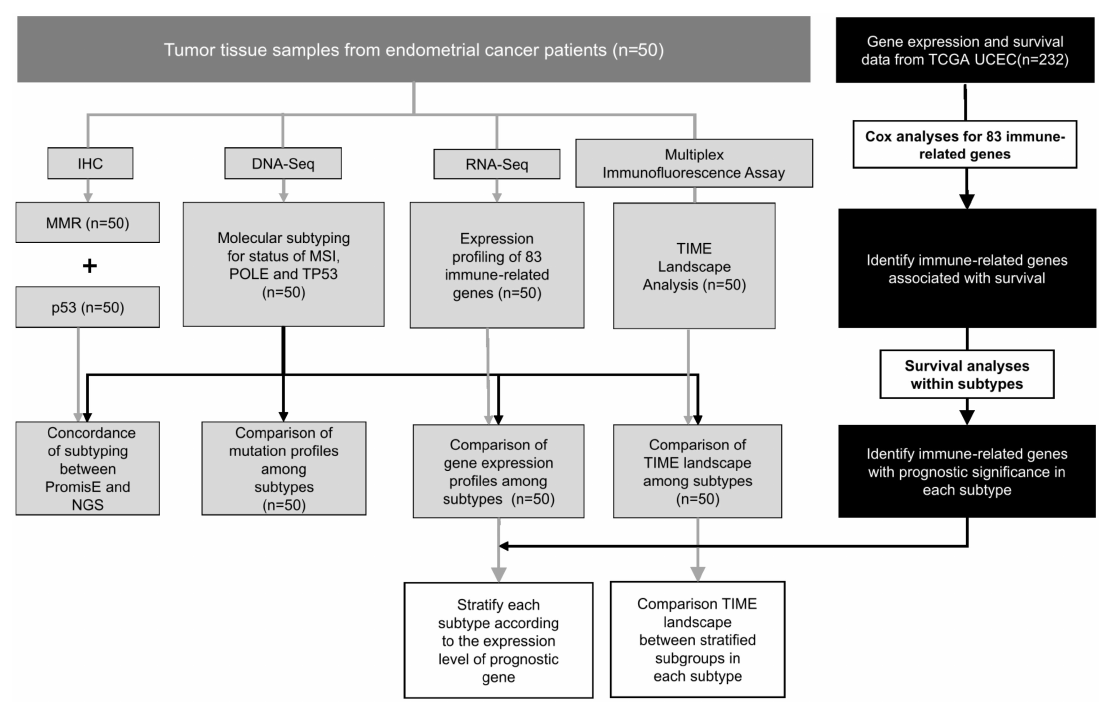
Figure 6. Flowchart of the study design. TCGA-UCEC: the Cancer Genome Atlas Uterine Corpus Endometrial Carcinoma; TIME: Tumor Immune Microenvironment; IHC: immunohistochemical assay; MMR: mismatch